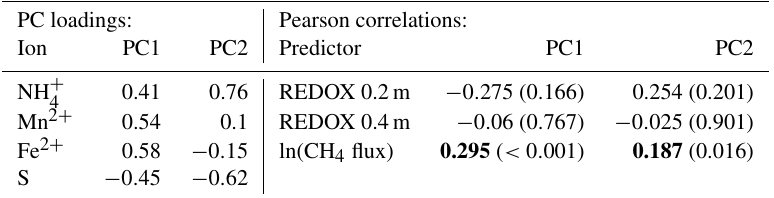
Table 4. PCA loadings and the Pearson correlation for principle components (PC) 1 and 2 and REDOX potential and log-transformed CH 4 flux ( p values given in parentheses). Methane fluxes were averaged over the same 1-month periods in which the PRS probes were buried. Bold numbers indicate significant correlations at α = 0 . 05, n = 25. PC loadings: Pearson correlations: Ion PC1 PC2 Predictor PC1 PC2 NH + 0.41 0.76 REDOX 0.2m − 0 . 275 (0.166) 4